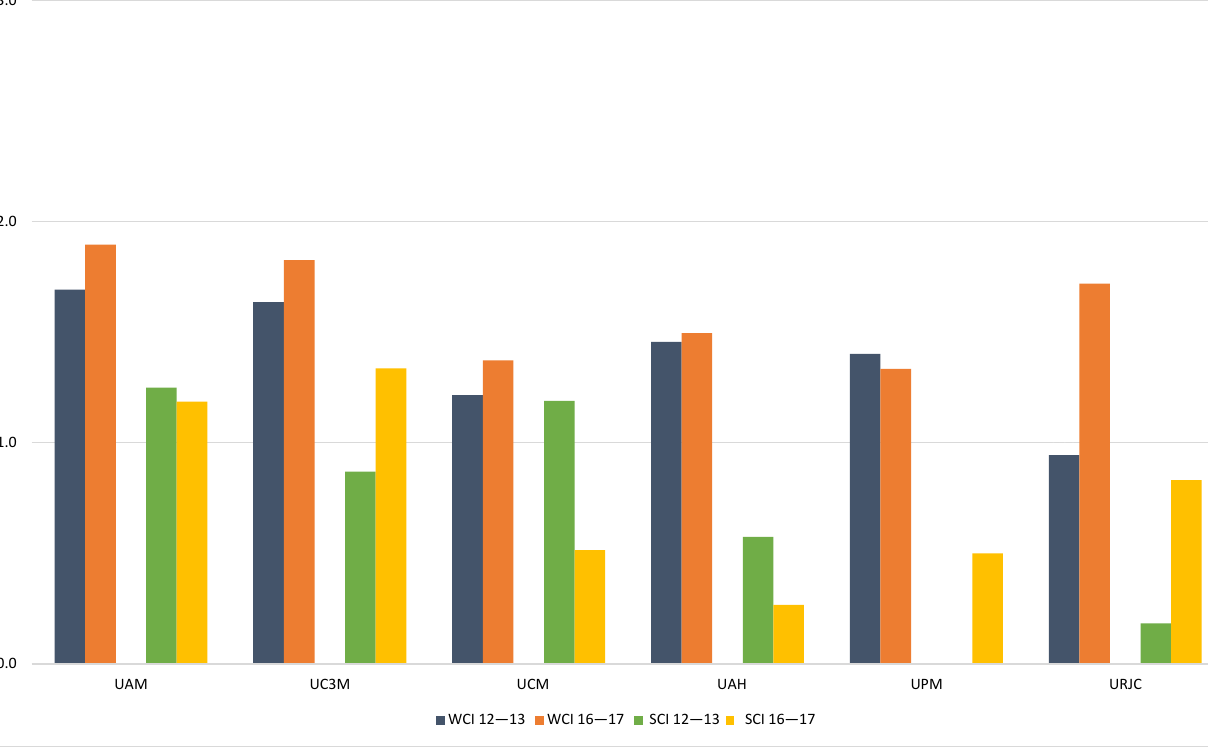
Figure 5. Evolution in the teaching mission of the Madrid public university system from 2012–2013 to